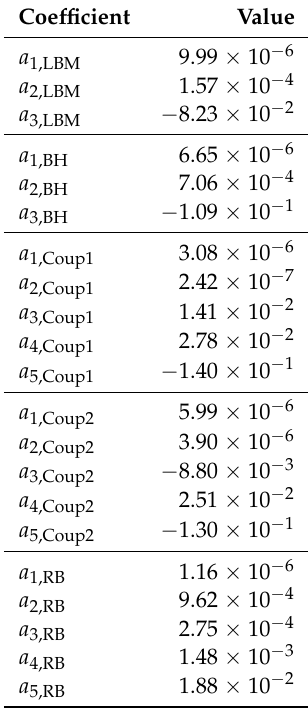
Figure 7. Box-and-whiskers plot of the proportion of the part’s runtime of total runtime, m X / m tot , for each sample. Table 2. Fitted values for the coefficients of Equations